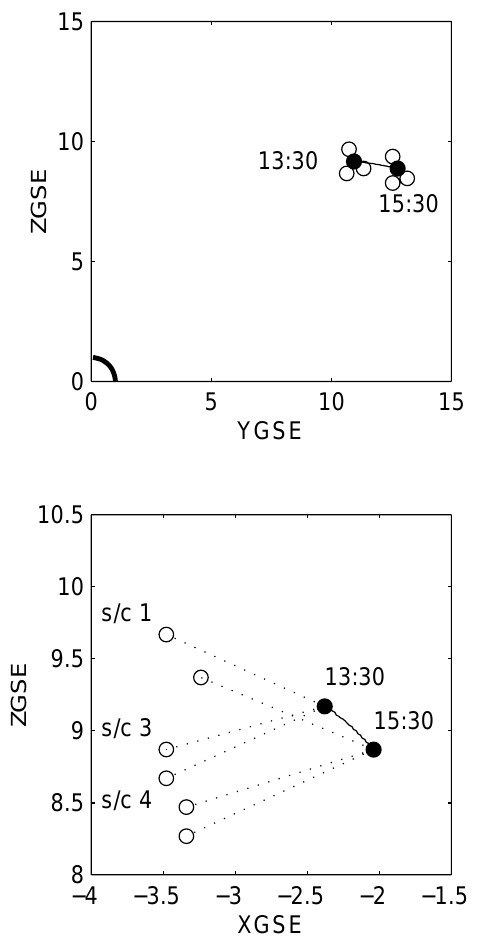
Fig. 7. Cluster orbit and configuration during 13:30–15:30 UT on 7 December 2000 in GSE YZ and XZ planes. The solid line and black dots show the location of spacecraft 2 (Salsa). In the bottom panel, the dashed lines join Salsa with the other spacecraft. For clar- ity reasons, the real inter-spacecraft distances have been multiplied by 10.